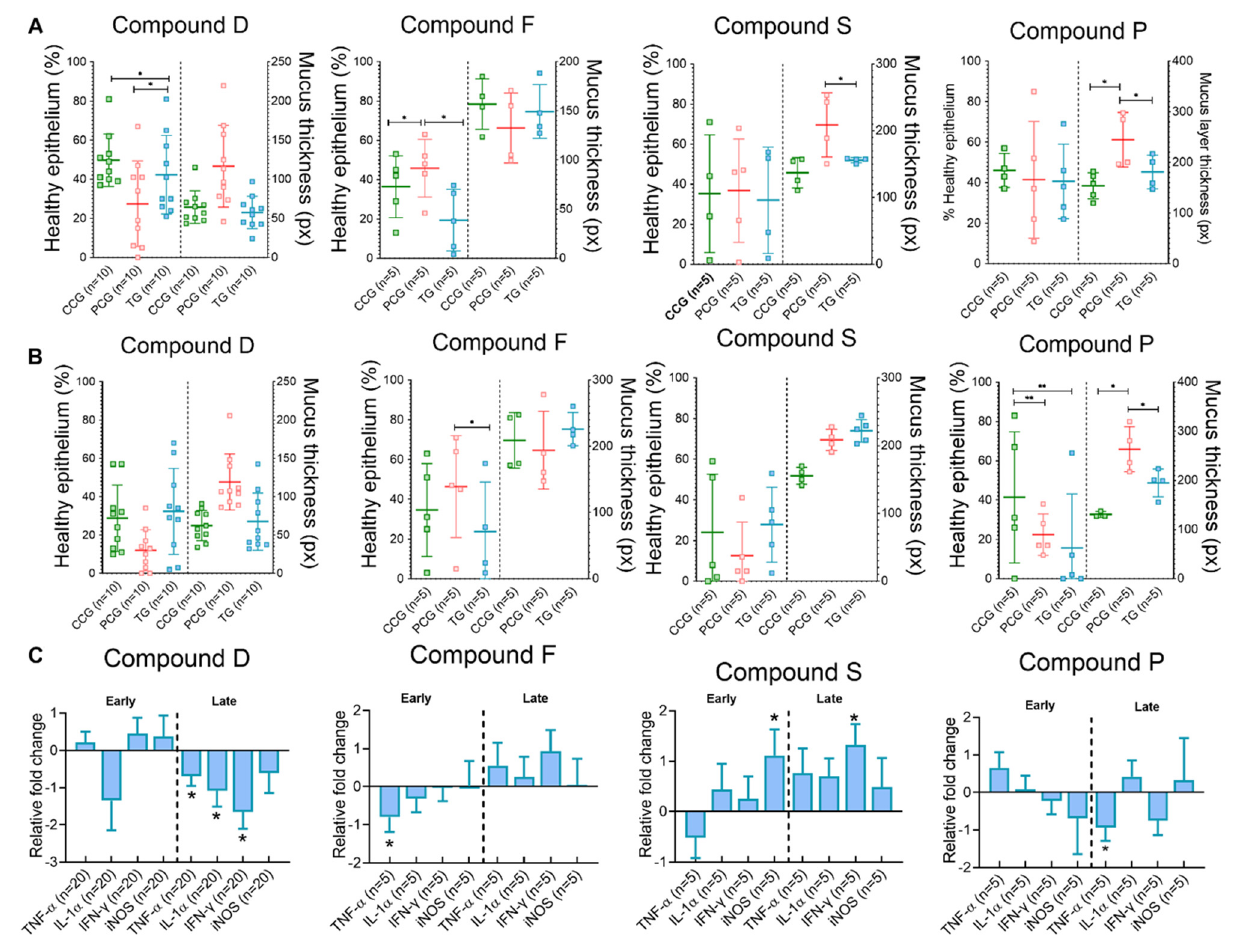
Figure 1. Microscopical changes and gene expression data from explants collected from 10 pigs and challenged with B. hyodysenteriae . ( A , B ) Histopathology assessment including the percentage of healthy epithelium covering explants and mucus layer thickness at early ( A ) and late ( B ) time- points. Horizontal lines represent group mean, and whiskers depict ± standard deviation from the mean. ( C ) Gene expression data is reported as fold change from TG samples using the PCG as reference. Compound control group (CCG), pathogen control group (PCG), treatment group (TG). Bars represent mean mRNA levels; whiskers depict standard deviation from the mean. Star denotes significant difference ( p ≤ 0.05) and two stars denote p = 0.06.